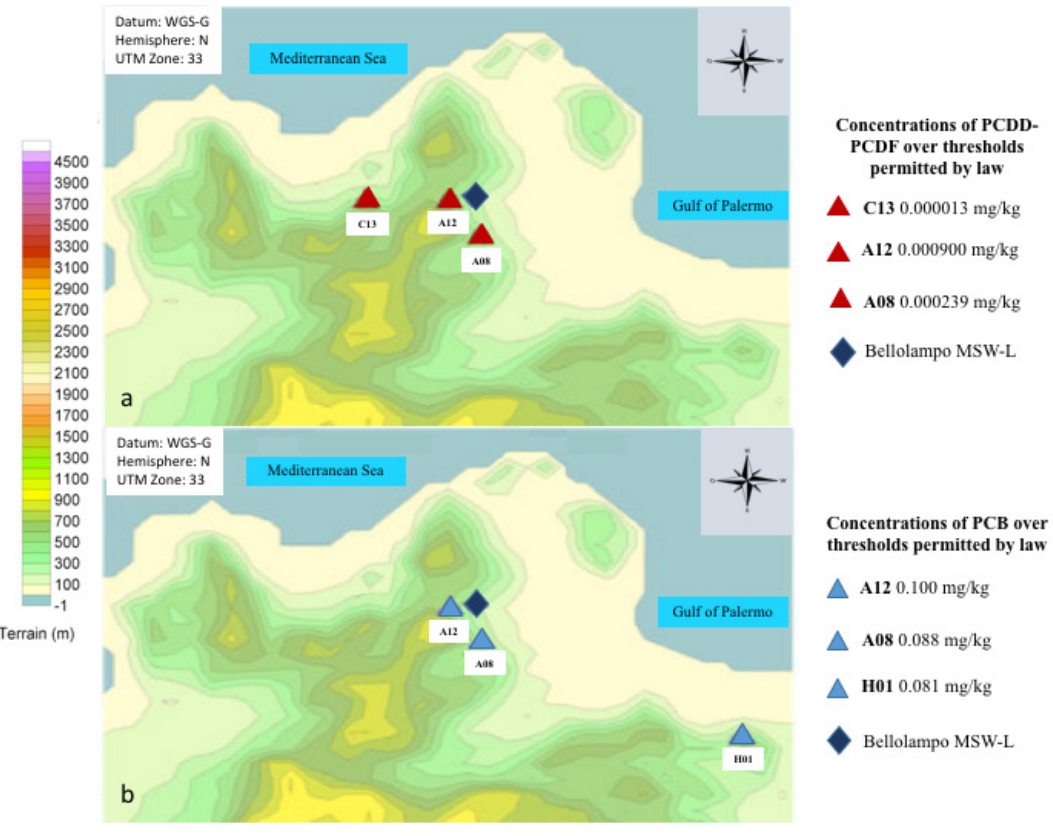
Figure 2. Concentrations of ( a ) PCDD-PCDF and ( b ) PCB over thresholds permitted by law detected in soil samples in the area under surveillance.